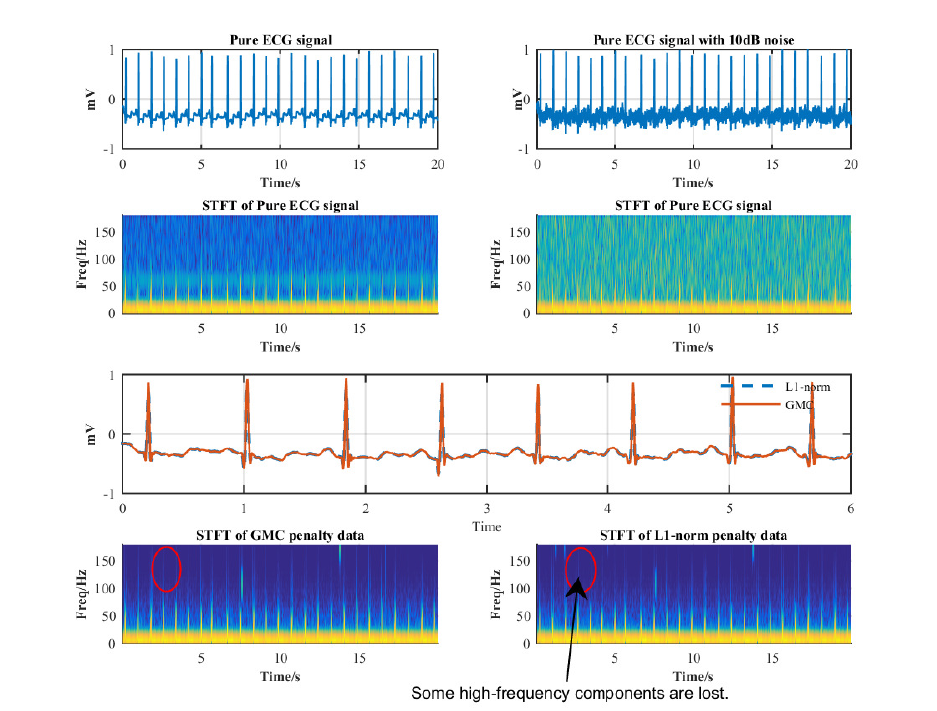
Figure 9. Comparison time-frequency properties of the GMC and (cid:96) 1 -norm